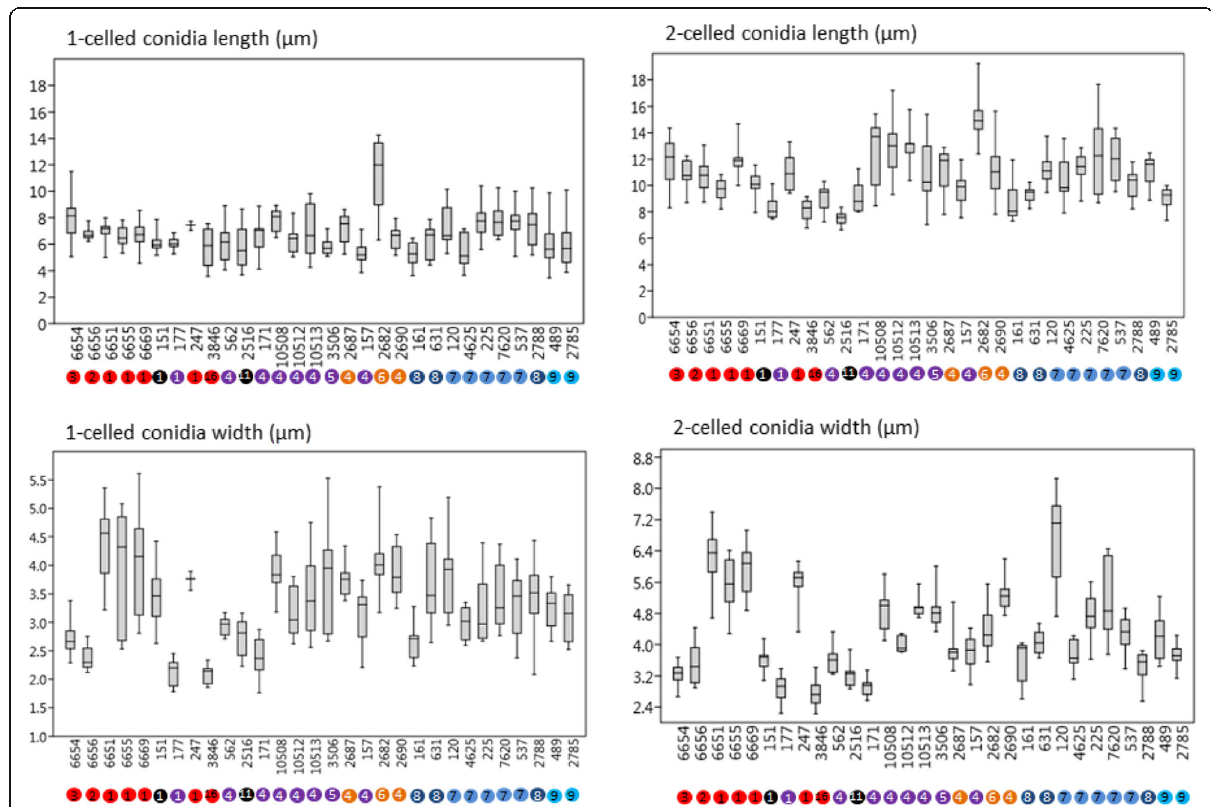
Fig. 14 Measurements of the 1-celled and 2-celled conidia of Hortaea werneckii strains. Data are means ±standard deviation. 28S rDNA genotypes are indicated as letters (genotype A, red; genotype B, C, D, blue; genotype E, violet; genotype F, orange; miscellaneous LSU genotypes, black), and ITS genotypes as numbers 1 –